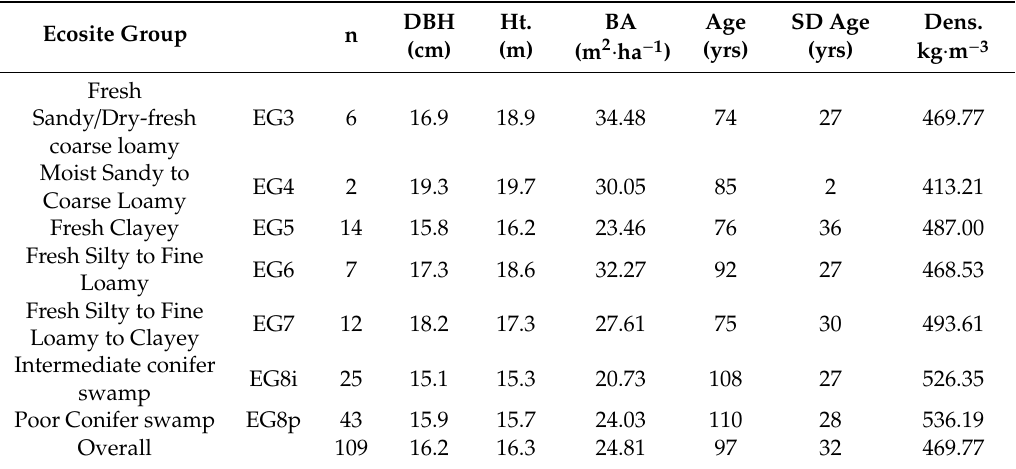
Table 2. Summary statistics for wood density and stand characteristics by ecosite groups in black spruce-dominated plots in the Hearst Forest in Northeastern